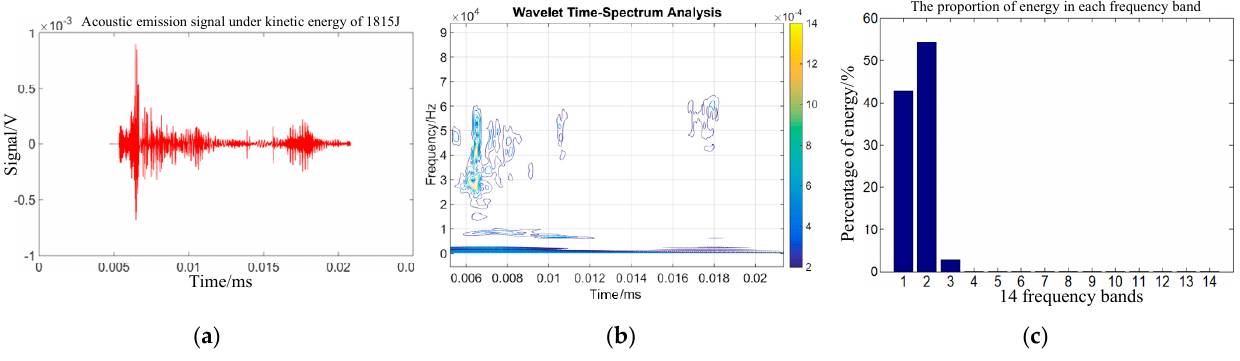
Figure 4. Time-frequency analysis of target sound emission signals under 1815 J kinetic energy. ( a ) Acoustic emission time domain waveform. ( b ) Sound emission wavelet time spectrum ( c ) Acoustic transmitted signals for each frequency band.